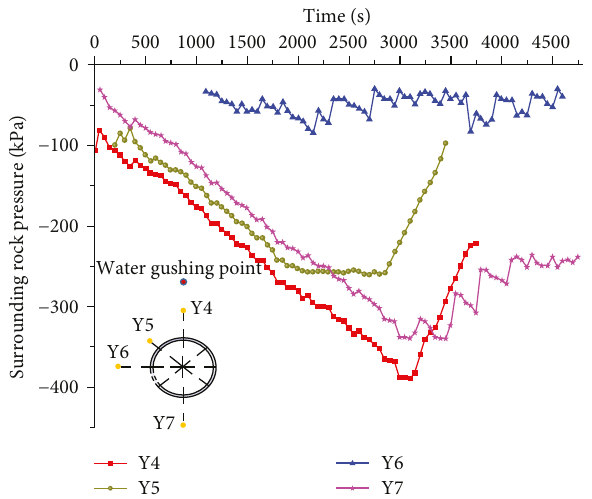
Figure 11: Surrounding rock pressure – time curves of Y4, Y5, Y6, and Y7.